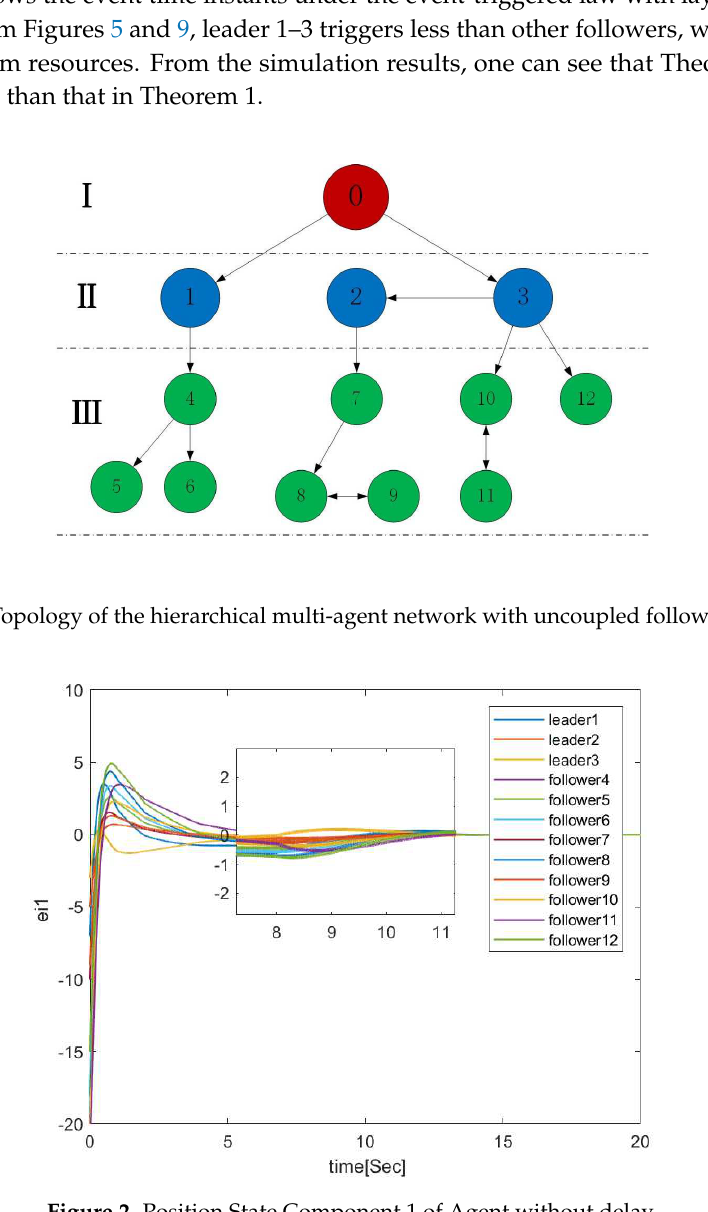
Figure 2. Position State Component 1 of Agent without